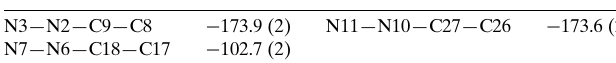
Table 1 Selected torsion angles ( (cid:3)